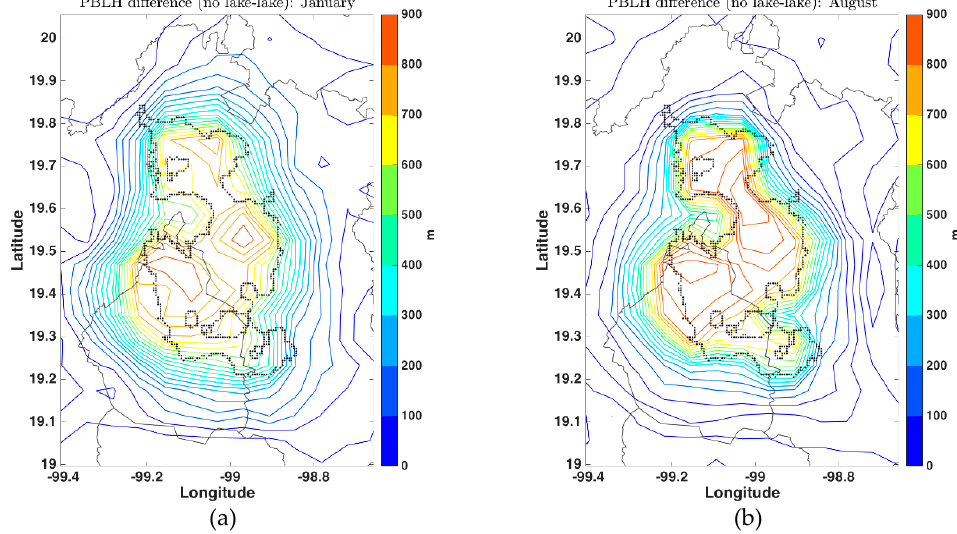
Figure 10. Di ff erence of mean maximum PBLHs between the NL / WRFc and L / WRFc simulations in January ( a ) and August ( b